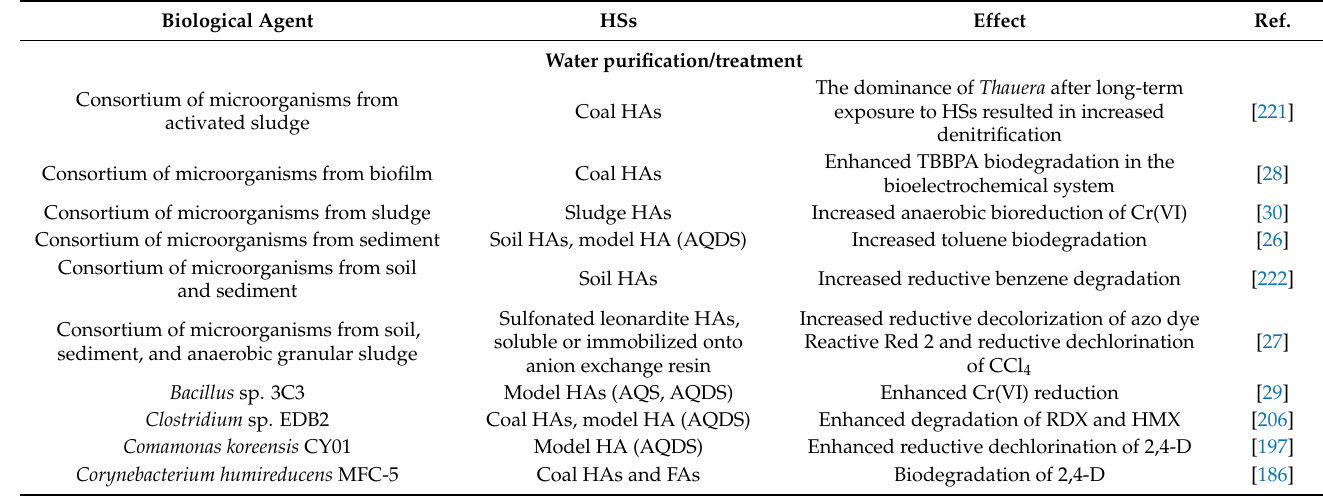
Table 5. Some of the microorganism–HS interactions that can support the development of nature-like bioremediation